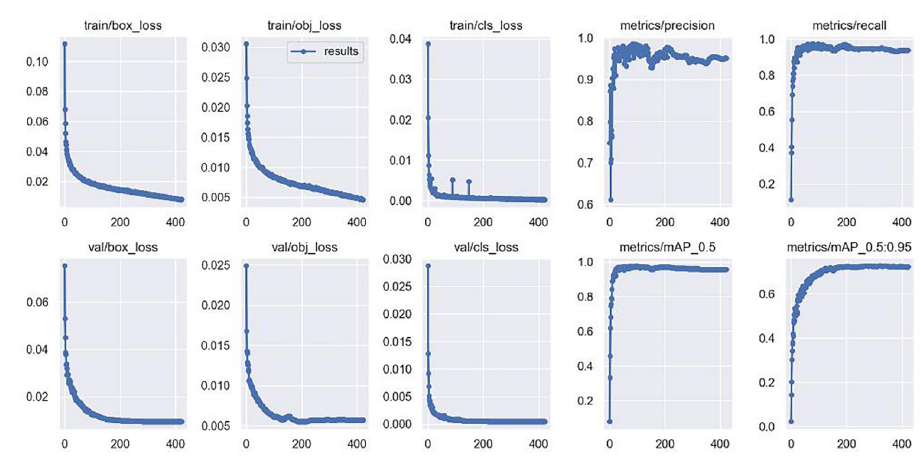
Fig 10. Training results of our network on the MSD dataset.